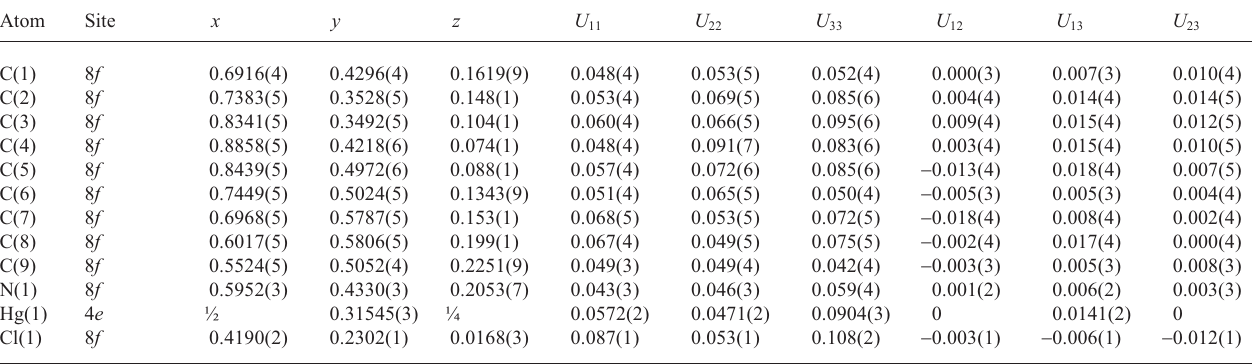
Table 3. Atomic coordinates and displacement parameters (in Å 2 )